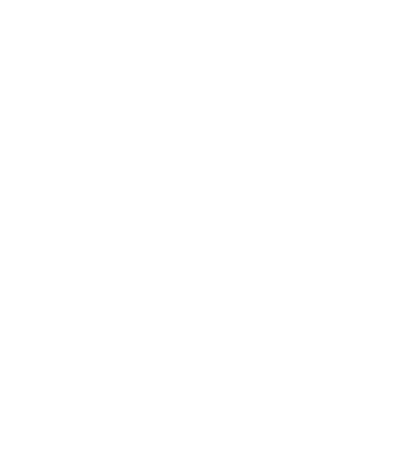
Figure 14. Comparison between the proposed model and two baseline models on the home- made dataset.